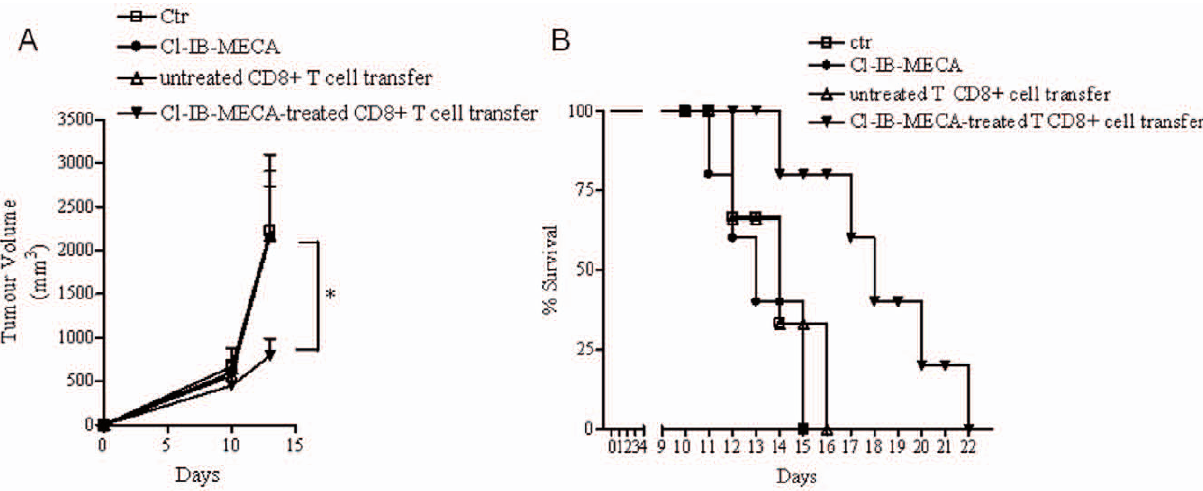
Figure 3. Tumor growth is inhibited in Nude mice adoptively transferred with CD8 + T cells stimulated with Cl-IB-MECA. A ) Tumor volume (mm 3 ) measured in melanoma-bearing Nude mice receiving a single dose of Cl-IB-MECA or adoptively transferred with Cl-IB-MECA-treated CD8 + T cells or with untreated CD8 + T cells. B ) Increased survival of melanoma-bearing Nude mice receiving CD8 + T cell transfer, cultured with Cl-IB- MECA (p , 0.01) compared with control groups and Cl-IB-MECA-treated mice (n=5/group). Data represent mean 6 SEM, n=6 in each of two independent experiments. Statistical difference was determined by one way ANOVA. *p , 0.05. Comparison of survival between groups was performed using long-rank